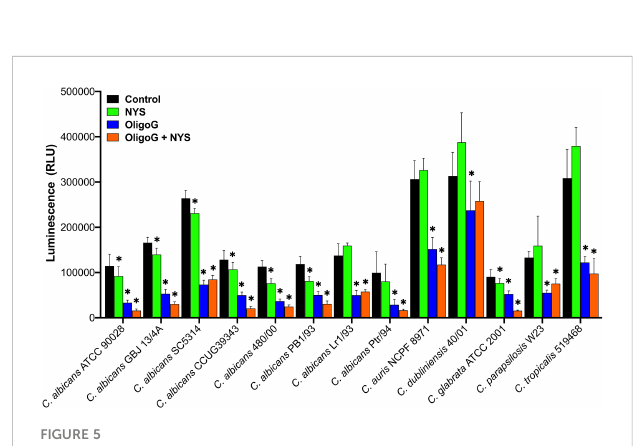
FIGURE 5 ATP cellular viability assay for bio fi lms of thirteen Candida spp. grown for 24 h prior to treatment with ± 4% OligoG ± nystatin (NYS; at MIC, 1-4 m g/ml) for a further 24 h (n=3). Group wise comparisons were analysed using one-way ANOVA followed by Tukey ’ s post hoc tests; * p < 0.05 compared to an untreated control. (All p values are shown in Supplementary Table 1).